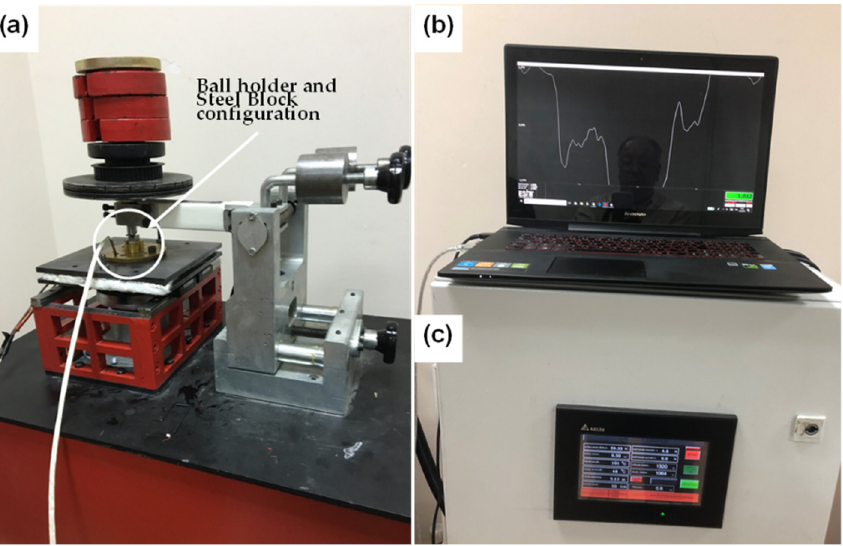
Figure 2. Reciprocating tribotest setup, ( a ) a general view, ( b ) recording of accurate friction force data measurement and ( c ) heating and temperature control and monitoring.